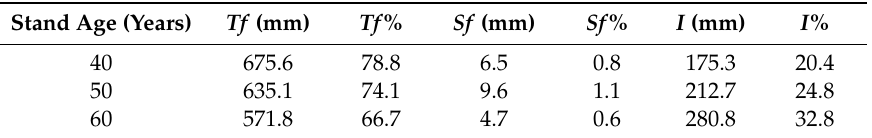
Table 4. Cumulative of throughfall, stemflow and interception in mm and percentages with concerning gross precipitation of three stand ages of Chinese pine forest from May to September of 2013 and 2014. Stand Age (Years) Tf (mm) Tf